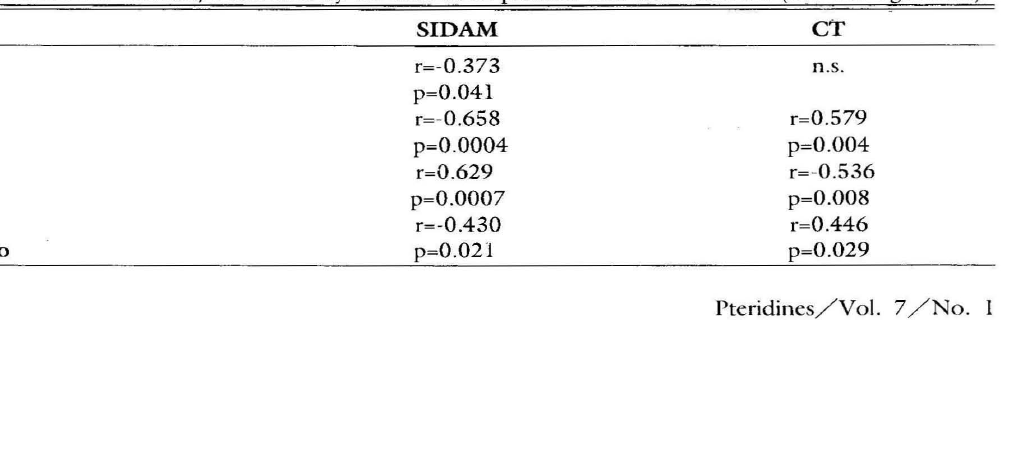
Table 2. Correlation coefficients and significance between serum parameters and cognitive impairement as reflected by the SIDAM test result and the ventricle/ brain ratio by CT scan in 32 patients with HIV infection (n.s.=not